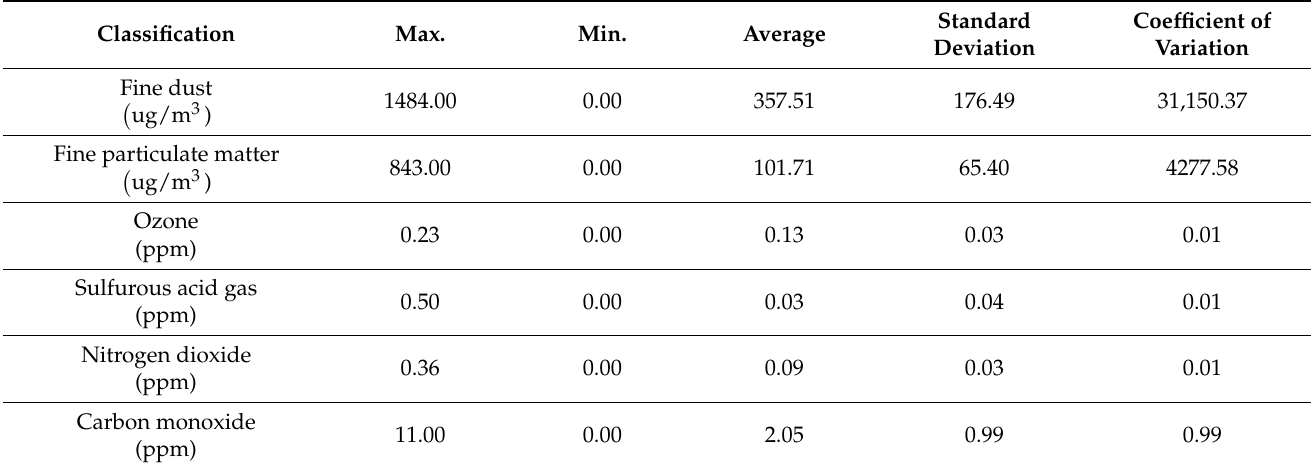
Table 1. Basic statistics for the variables.